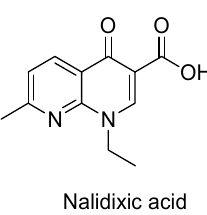
Figure 1. Chemical structure of nalidixic acid.